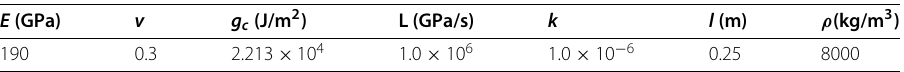
Table 5 Material properties used in the tensile dynamic fracture simulations, taken from (Borden et al.